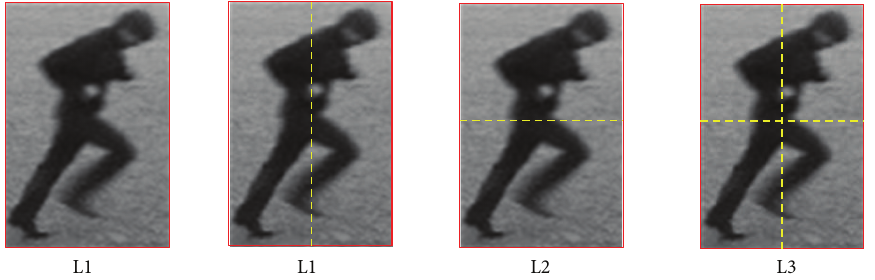
Figure 5: Confusion matrix for KTH dataset of our methods LGSR and MLSC.